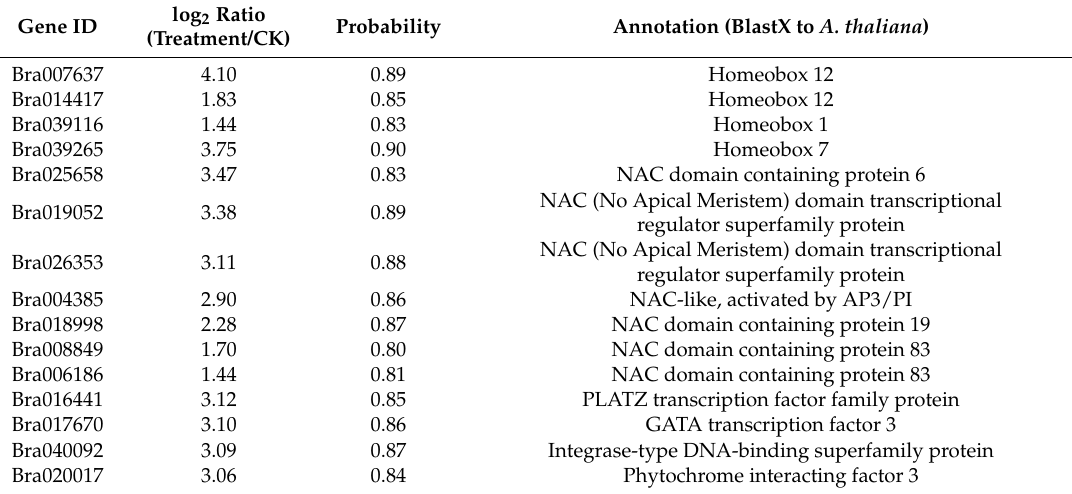
Table 3. The up-regulated DEGs encoding transcription factors in Chinese